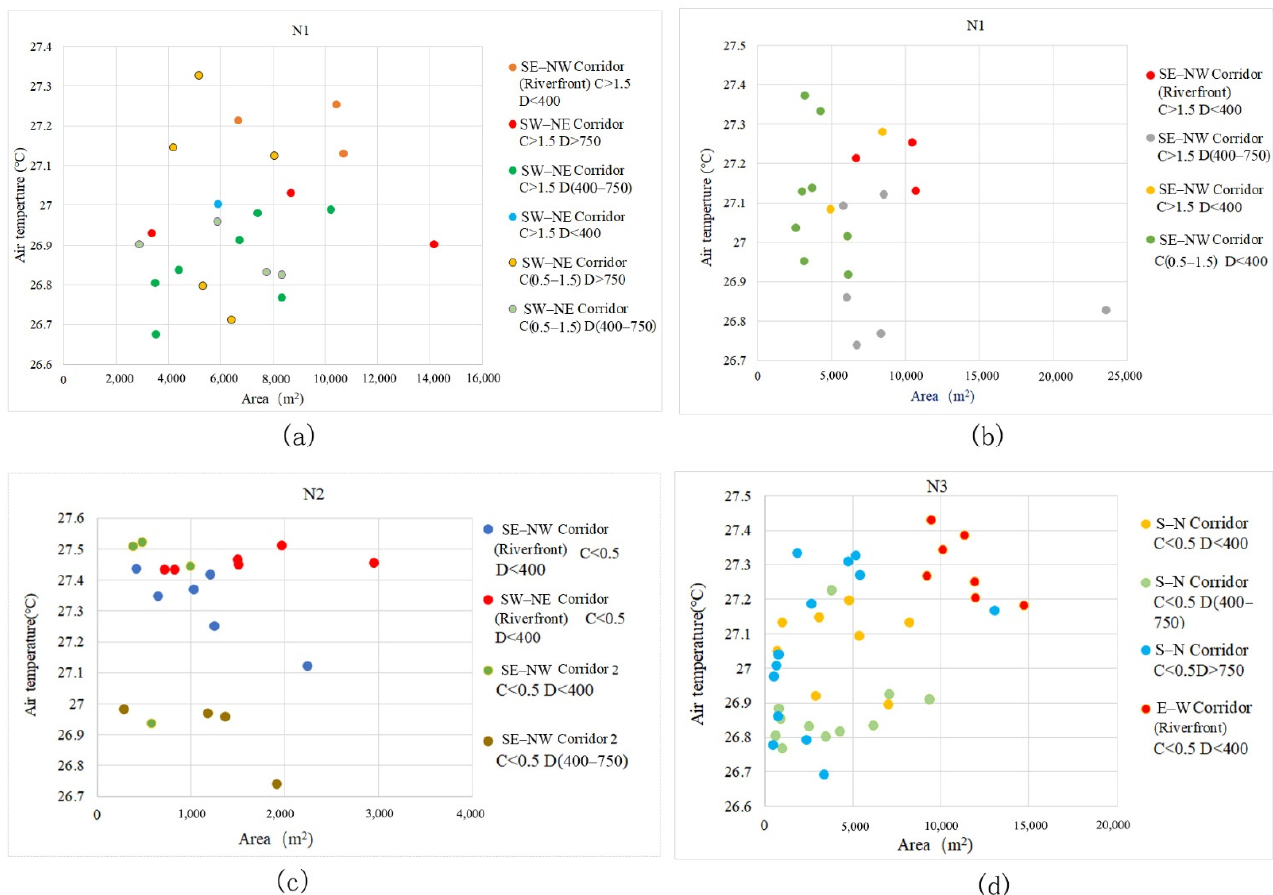
Figure 7. Scatter diagrams of green corridor segments with different D value grades and their corresponding Ta distributions. ( a ) In block N1, the distribution of Ta corresponding to green corridor D with the same WS–EN orientation indicates that when the dPC values of green corridors have the same grade, the values are more than 0.5 and the most corresponding T values in the low-temperature location belong to D values between 400 m and 750 m. ( b ) In block N1, with the same ES–WN orientation, the green corridor segments with a range of D from 400 m to 750 m also have the lowest Ta values. ( c ) In block N2, with the same ES–WN orientation, the D factor significantly affects the Ta distribution. When D is within 400 m, the cooling is attenuated with an increase in distance. When the D values of the green corridor segments are within 400–750 m grade with the same dPC and orientation, the internal Ta values in the green corridor segments are also the lowest. ( d ) In the green corridors of block N3 with an S–N orientation, the relationship between D and Ta still indicates the characteristic that the internal Ta value is low when D is within the 400–750 m grade.